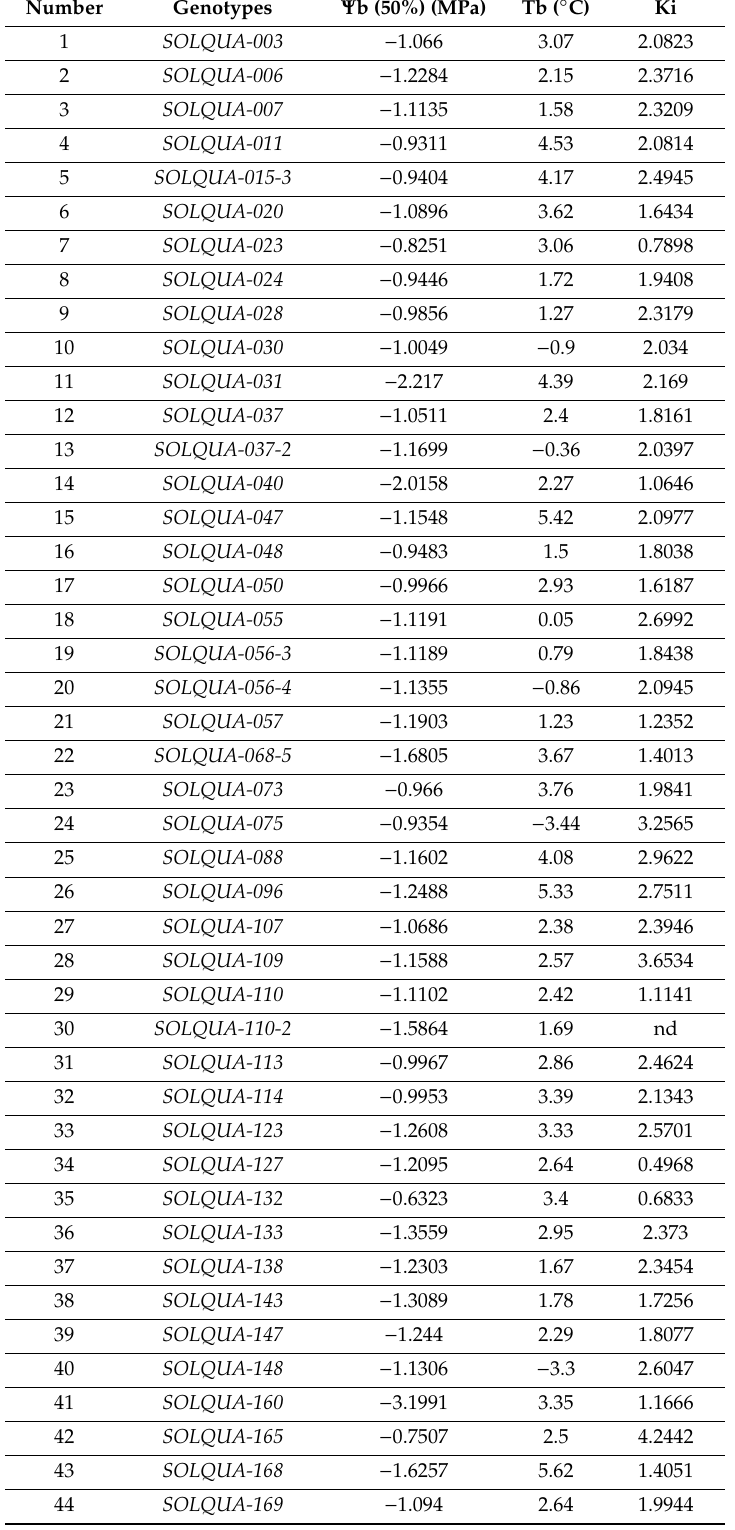
Table 1. Seed vigor parameters, base water potential ( Ψ b, 50%), base temperature (Tb) and viability constant (Ki) of seeds of the 44 genotypes. nd: non